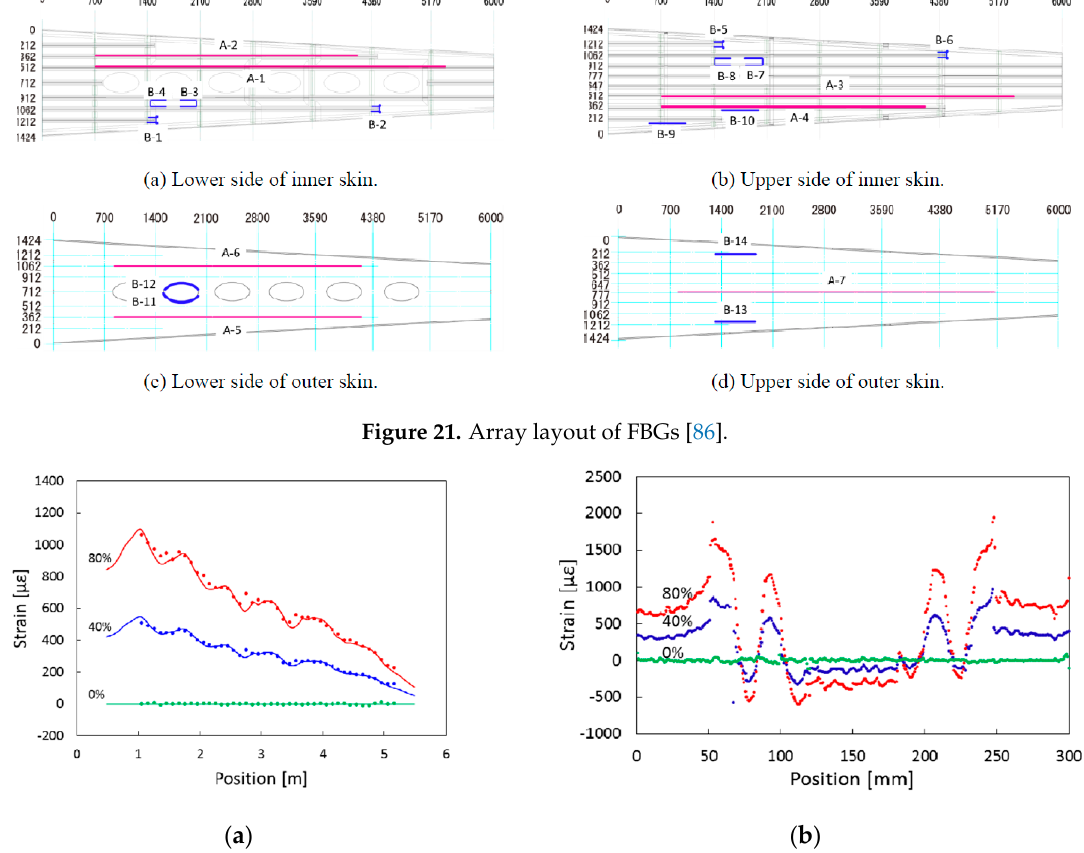
Figure 22. ( a ) Strain distributions measured by A-1; ( b ) Strain distributions measured by B-1 [86].